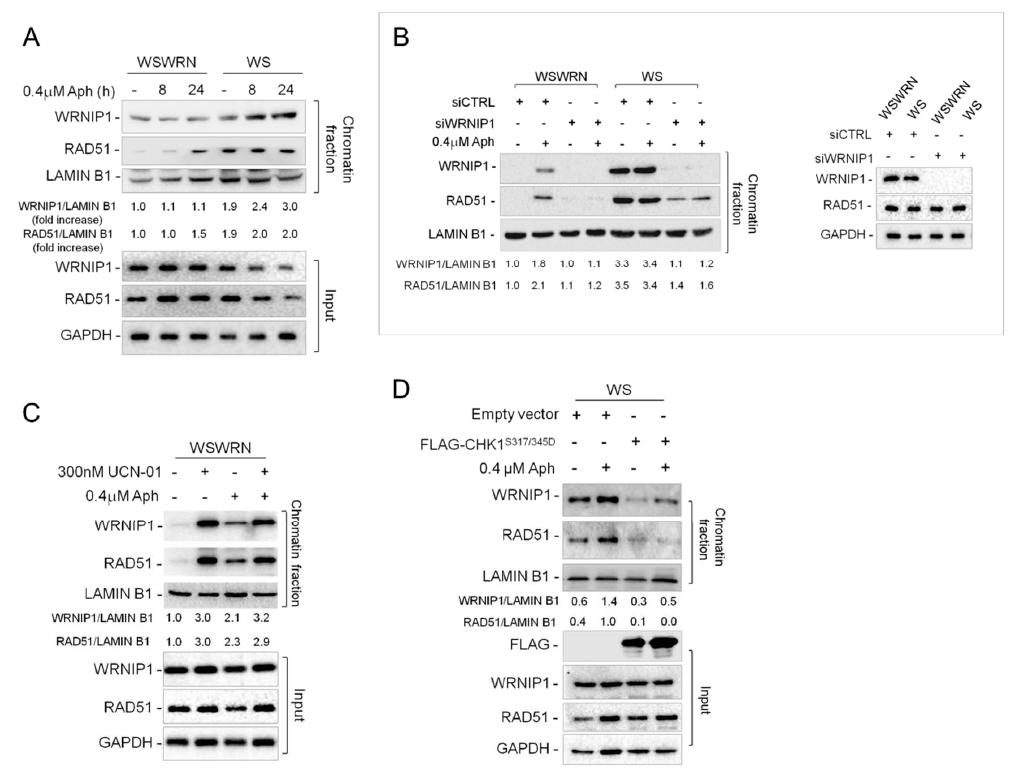
Figure 5. WRNIP1 stabilizes RAD51 on chromatin in WS cells. ( A ) WB analysis of chromatin binding of WRNIP1 and RAD51, performed as in Figure 2A, in WSWRN and WS cells treated with Aph for different times. The membrane was probed with the indicated antibodies. The normalized ratio of the chromatin-bound WRNIP1/LAMIN B1 or RAD51/LAMIN B1 are given; ( B ) WB analysis of chromatin binding of WRNIP1 and RAD51, performed as in Figure 2A, in WSWRN and WS cells transfected with GFP or WRNIP1 siRNA treated with Aph for 24 h. The membrane was probed with the indicated antibodies. The normalized ratio of the chromatin-bound WRNIP1/LAMIN B1 or RAD51/LAMIN B1 are given; ( C ) WB analysis of chromatin binding of WRNIP1 and RAD51, performed as in Figure 2A, after CHK1 inhibition. WSWRN cells were treated with Aph, and/or to 300 nM of CHK1 inhibitor, UCN-01, for the last 6 h. The membrane was probed with the indicated antibodies. The normalized ratio of the chromatin-bound WRNIP1/LAMIN B1 or RAD51/LAMIN B1 are given; ( D ) WB analysis of chromatin binding of WRNIP1 and RAD51, performed as in Figure 2A. WS cells were transfected with empty vector or FLAG-tagged CHK1 317/345D and treated with Aph. The membrane was probed with the indicated antibodies. The normalized ratio of the chromatin-bound WRNIP1/LAMIN B1 or RAD51/LAMIN B1 are given.